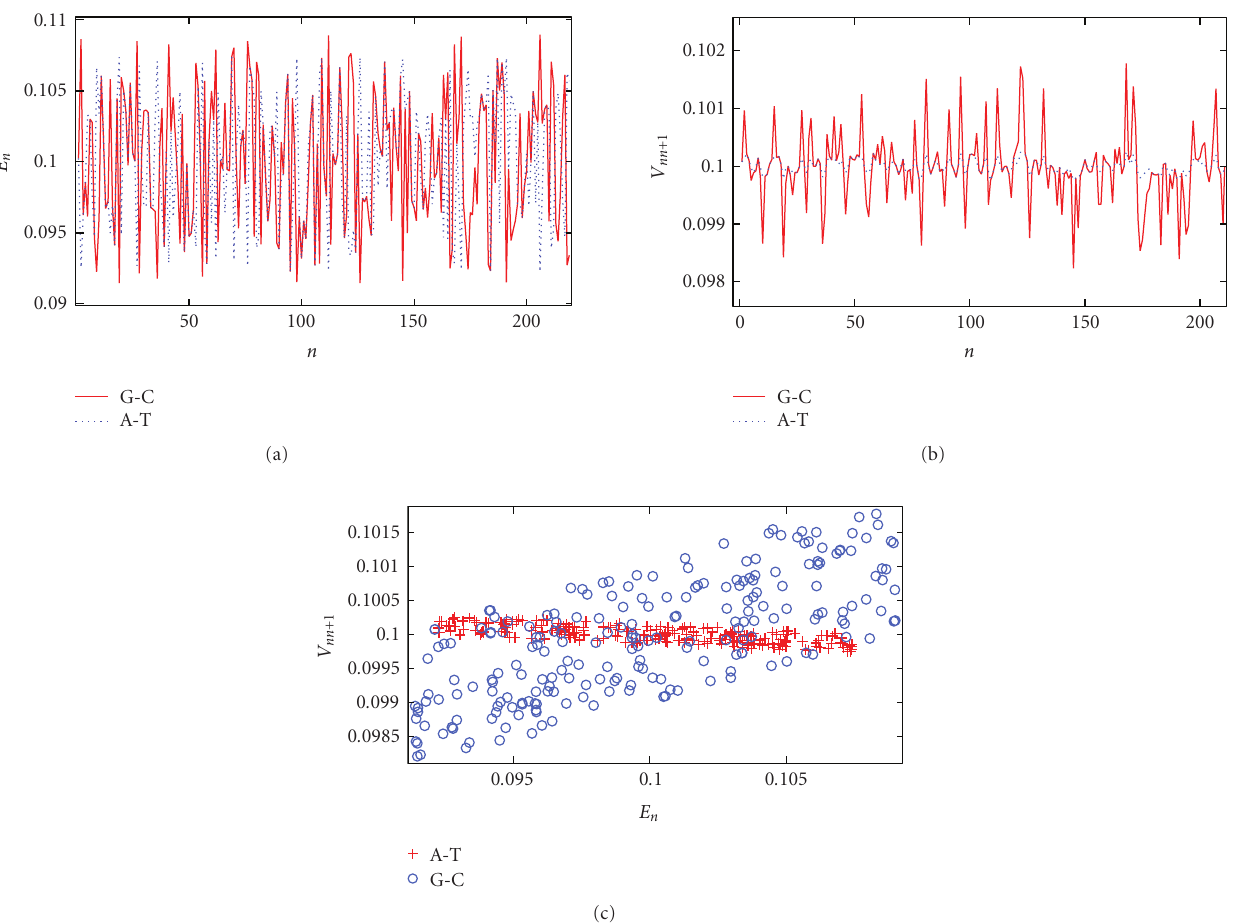
Figure 4: (a) The on-site energy E n eV and (b) transfer integral V nn +1 eV as a function of the base pair site n . The parametric plot E n versus V nn +1 is shown in (c). W = 0 . 1 and the other parameters are given in text. The unit of the energy and the spatial length are eV and the number of nucleotide base pair (bp), respectively, throughout the present